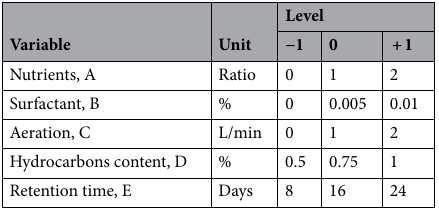
Table 1. Summary of experimental factors and